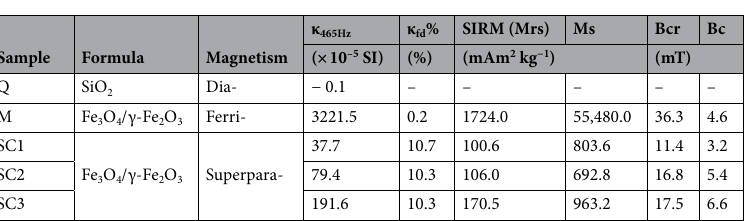
Figure 2. Thermomagnetic measurements of the tested samples: ( a ) magnetite/maghemite (M); ( b ) soil concretions (SC1-3). T temperature; κ volume magnetic susceptibility.